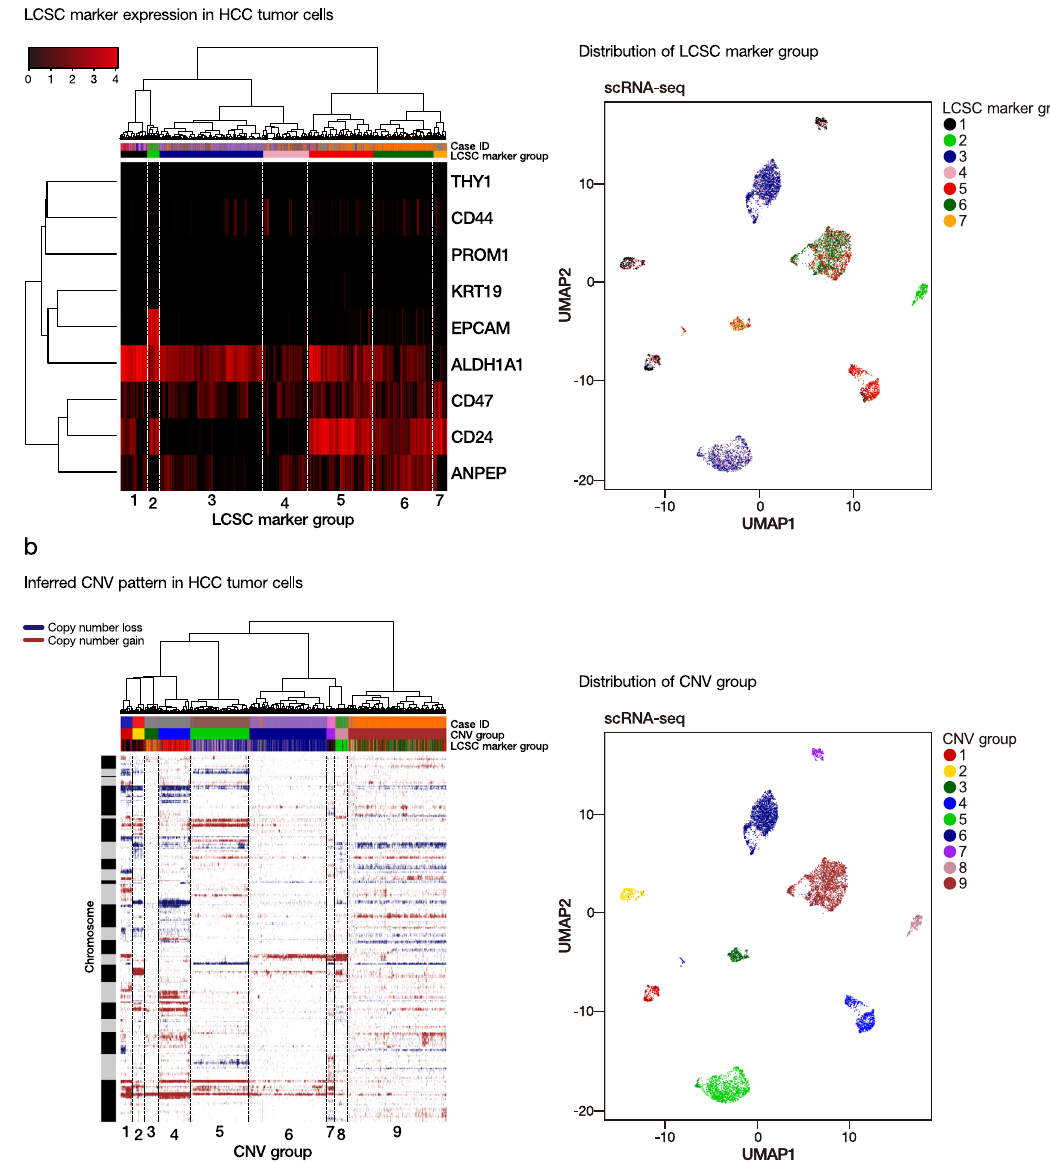
Fig. 6 Tumor heterogeneity in terms of LCSC marker and inferred CNV status. a We strati fi ed the HCC tumor cells according to LCSC marker expression into different LCSC marker groups (left). The distribution of LCSC marker groups was displayed in the UMAP plot (right). b HCC tumor cells were also strati fi ed according to inferred CNV patterns into different CNV groups (left). The distribution of CNV groups was displayed in the UMAP plot